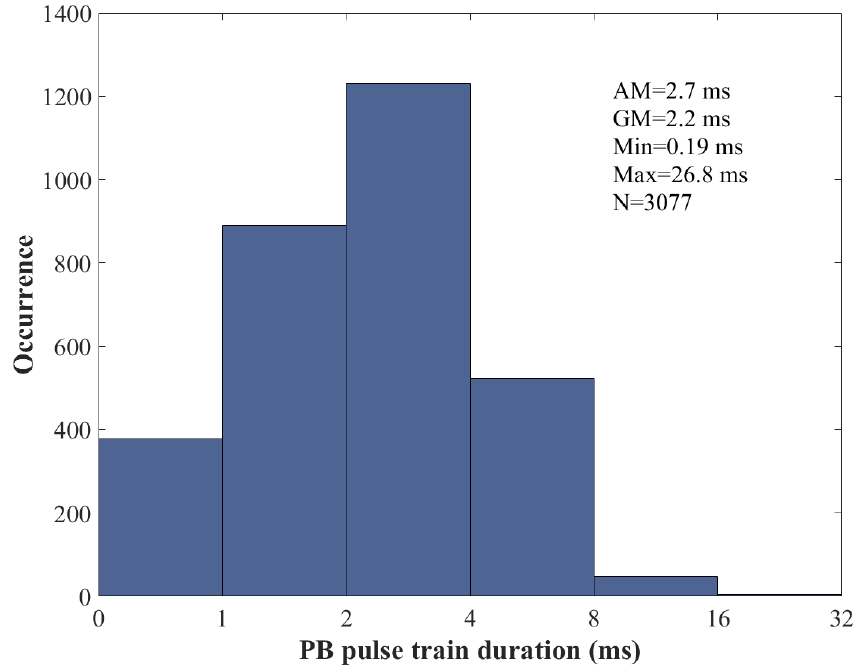
Figure 7. Histogram of PB pulse train duration for the 3077 flashes.